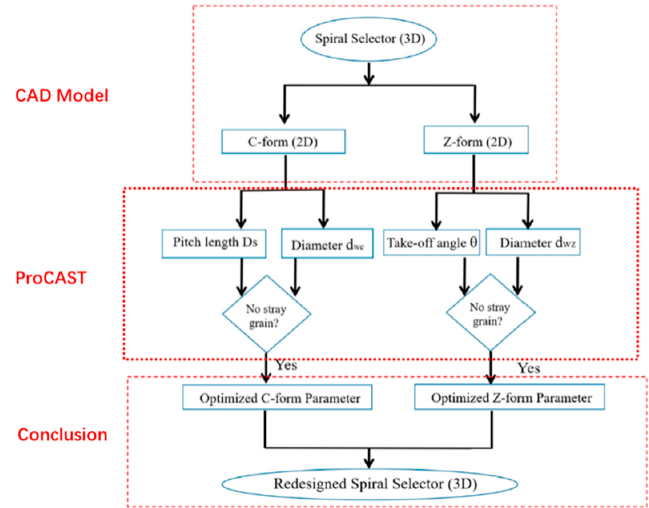
Figure 2. The flow chart of find a high-e ffi cient grain selector using the reduction dimensional